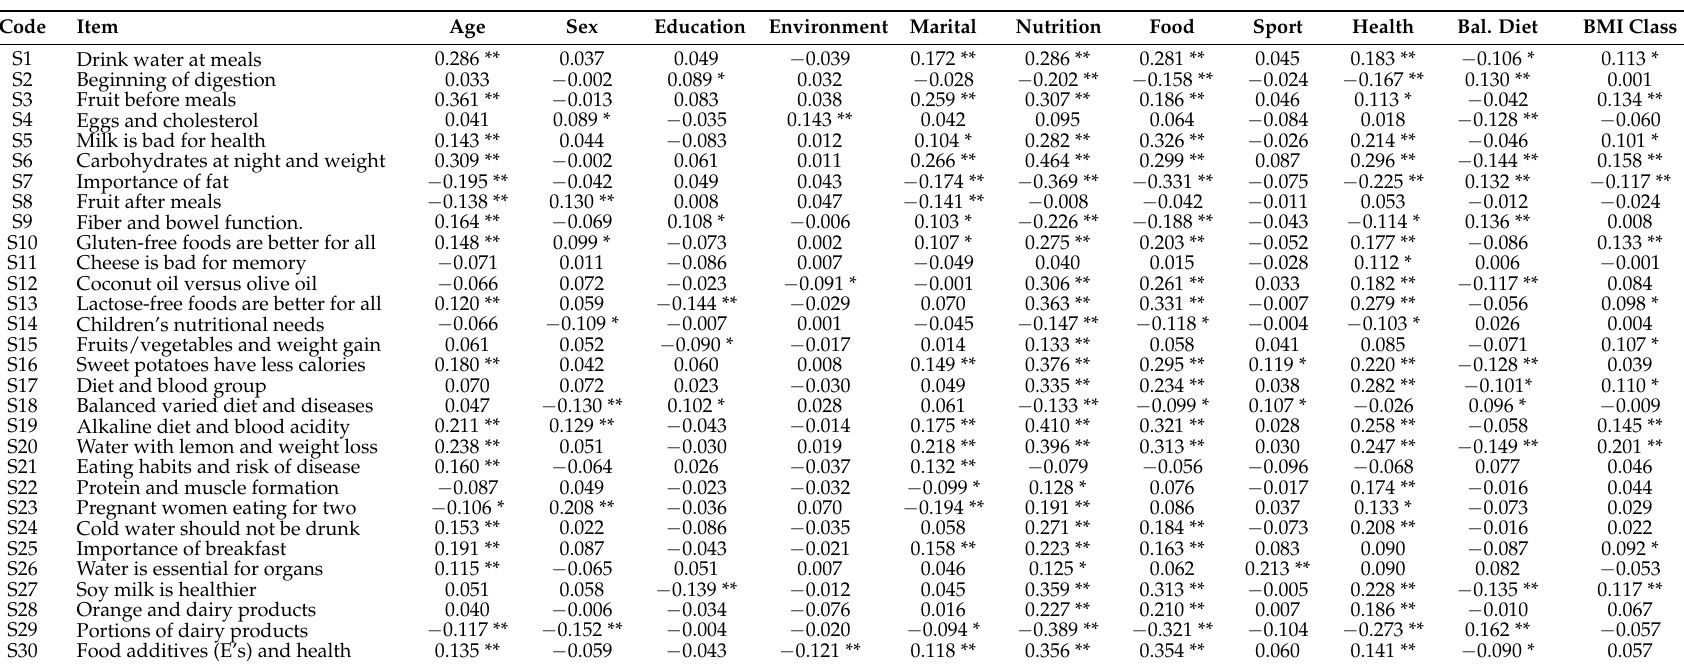
Table A1. Values of Spearman correlation between perception about the food myths/facts and some sociodemographic, anthropometric, and behavioral variables.